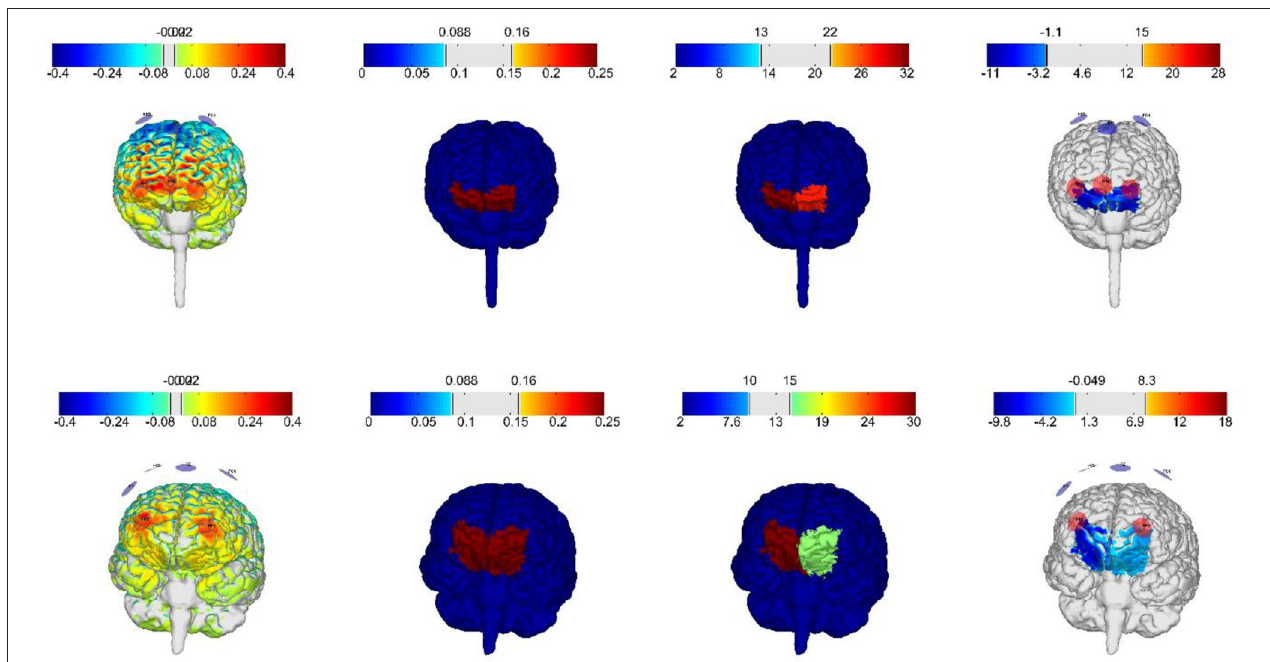
FIGURE 2 | Electric field distributions on gray matter with current intensities within the established safety range for adolescents, generated by the optimized montages for vmPFC from Neuroelectrics. First row: female frontal brain view, second row: male frontal brain